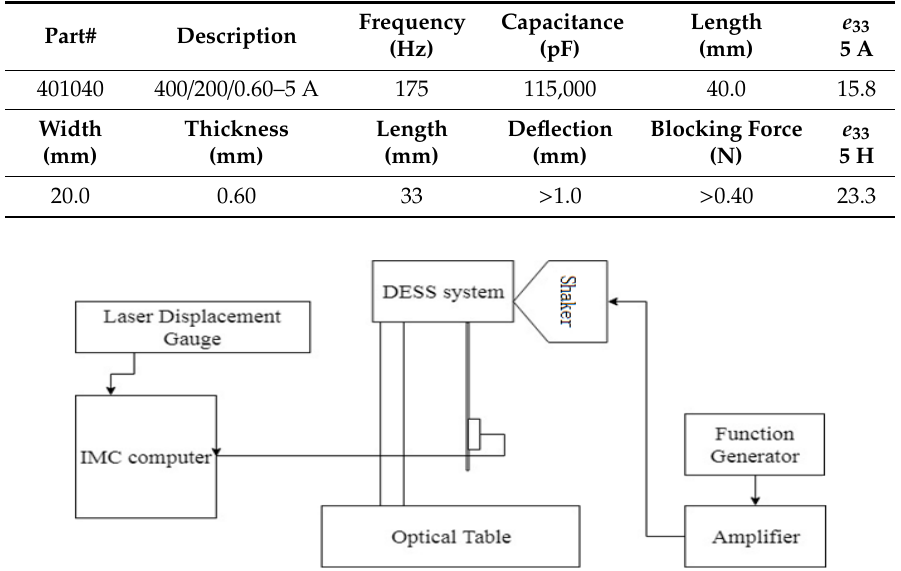
Figure 3. Experimental flow chart.